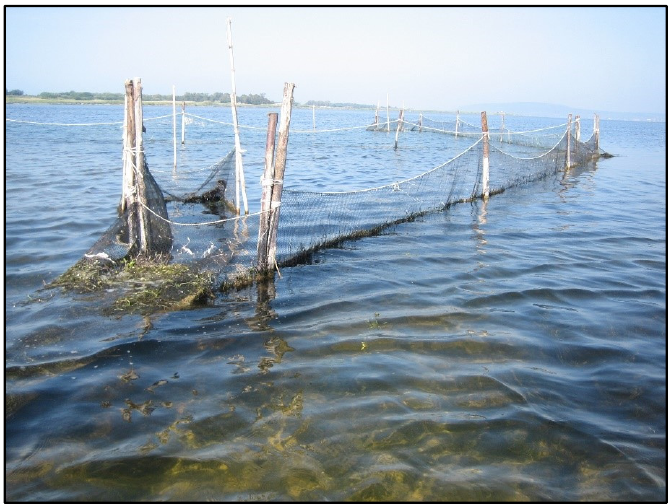
Figure 6. Artisanal stake-nets in Lesina Lagoon (Image: Ram ū nas Povilanskas).